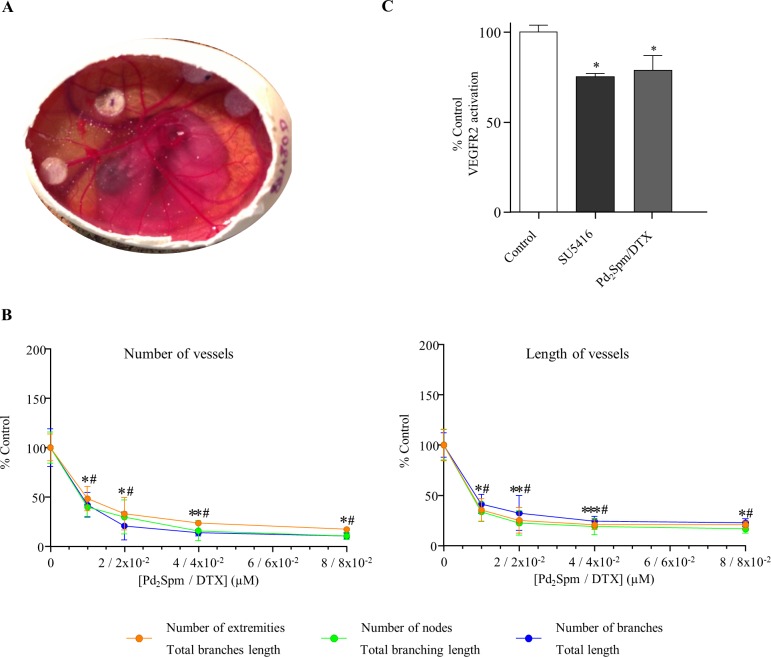
Combination effect of DTX and Pd2Spm on angiogenesis.Eight days after fertilization, Pd2Spm/DTX, VEGF (positive control) or PBS (negative control) was added to the coverslip (previously sterilised and treated with hydrocortisone). After incubating the eggs for 48 hours, the CAMs were peeled off and photographed. Digital images were analysed using the Angiogenesis Analyser for Fiji [25]. (A)–representative digital CAM image; (B)–quantitative CAM angiogenesis in the presence of increasing concentrations of Pd2Spm/DTX; (C) Inhibition of VEGFR2 activity in the presence of IC50 concentrations of Pd2Spm/DTX (determined by the CAM assay) and SU5416 –semaxanib (VEGFR2 inhibitor). The results are expressed as a percentage of the control ± SEM. The one-way ANOVA statistical analysis was used, and the Dunnett’s post-test was carried out to verify the significance of the obtained results (*p<0.05 versus the control).